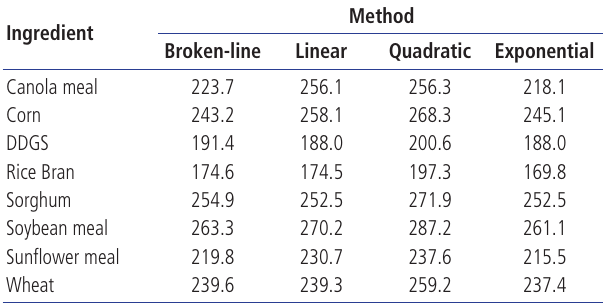
Table 2. Analyzed concentration of total phosphorus in test ingredients Ingredient